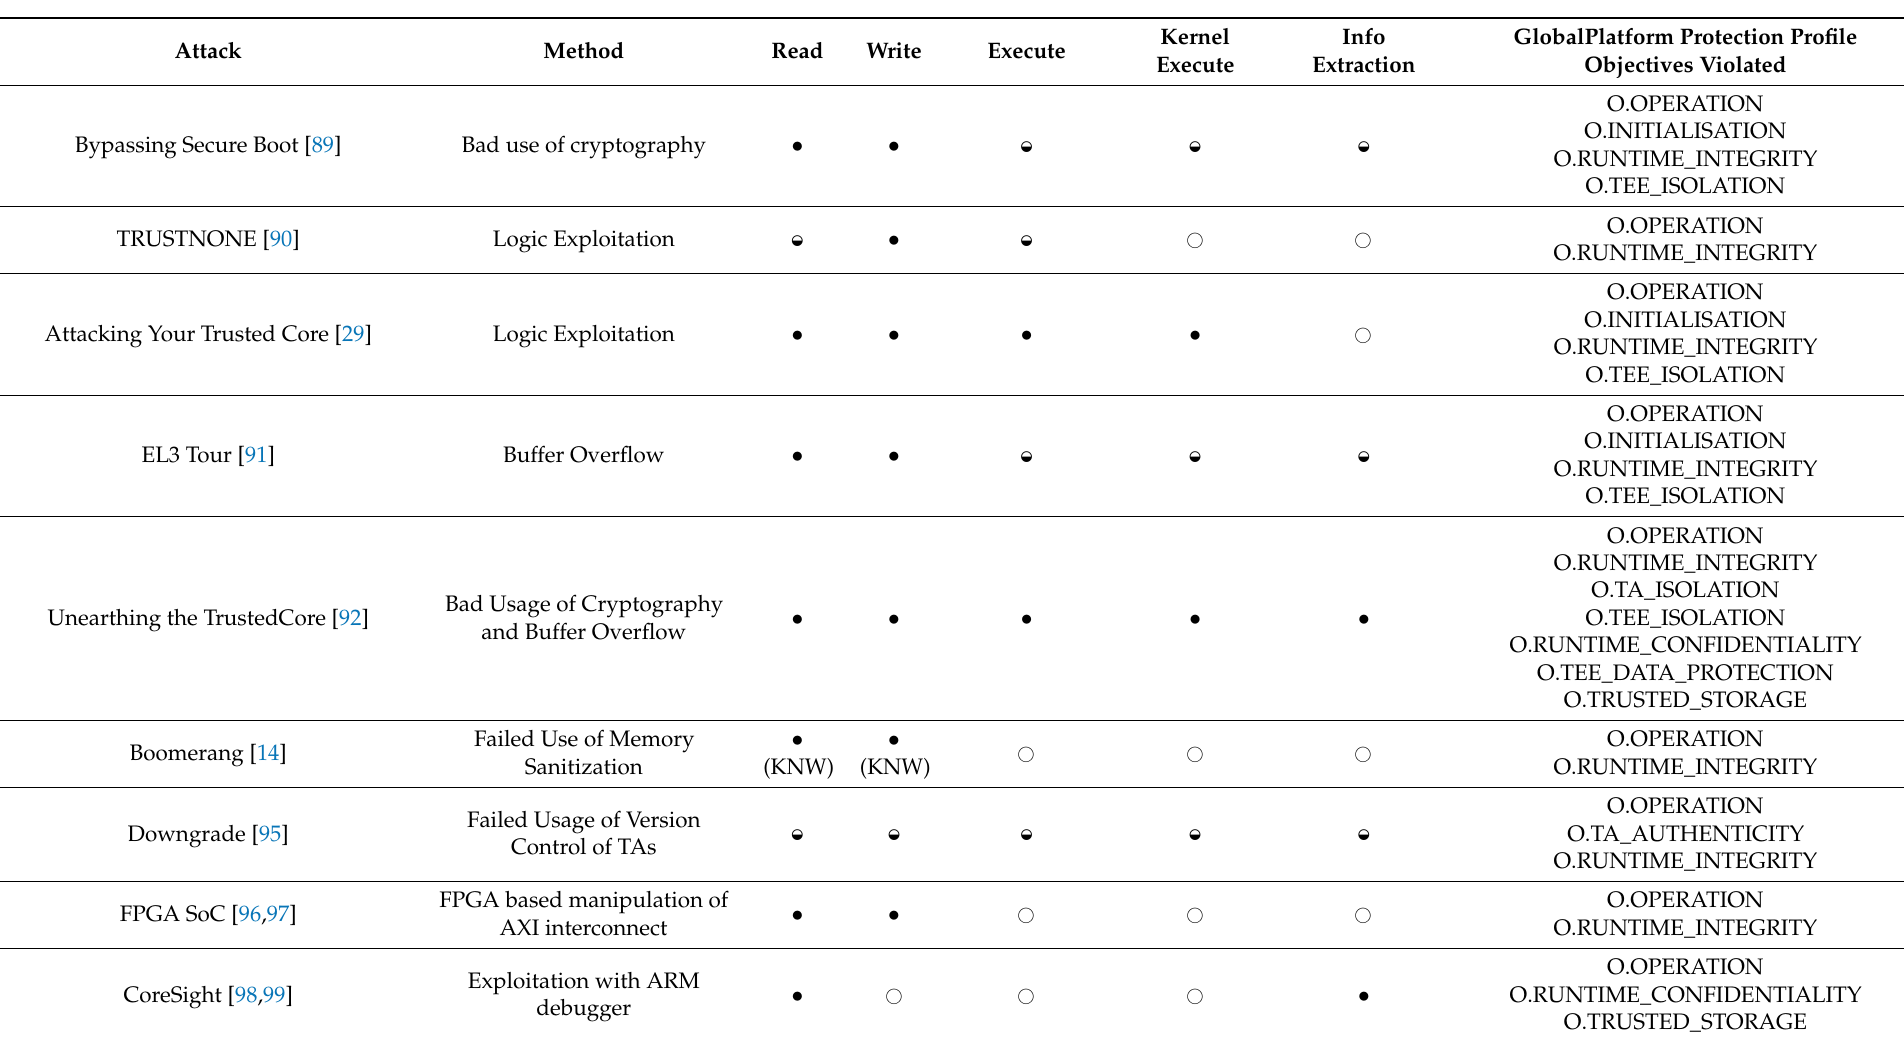
Table 2. A comparison of the analyzed attacks that showcases the methodology used, the primitives achieved, and the GlobalPlatform Protection Profile objectives violated by each attack. The Kernel Normal World (KNW) mark shows that the primitive targets the kernel of the normal world. ( ○ Not achieved ◒ Not achieved but trivial ● Achieved).